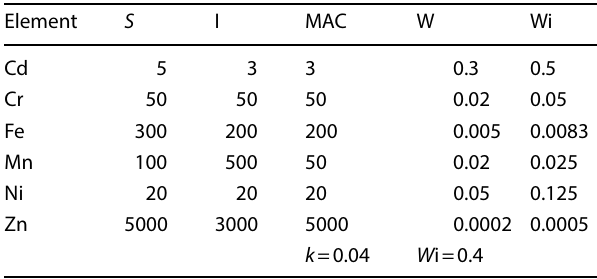
Table 1 Standards used for the computation of the pollution indi- ces in this study